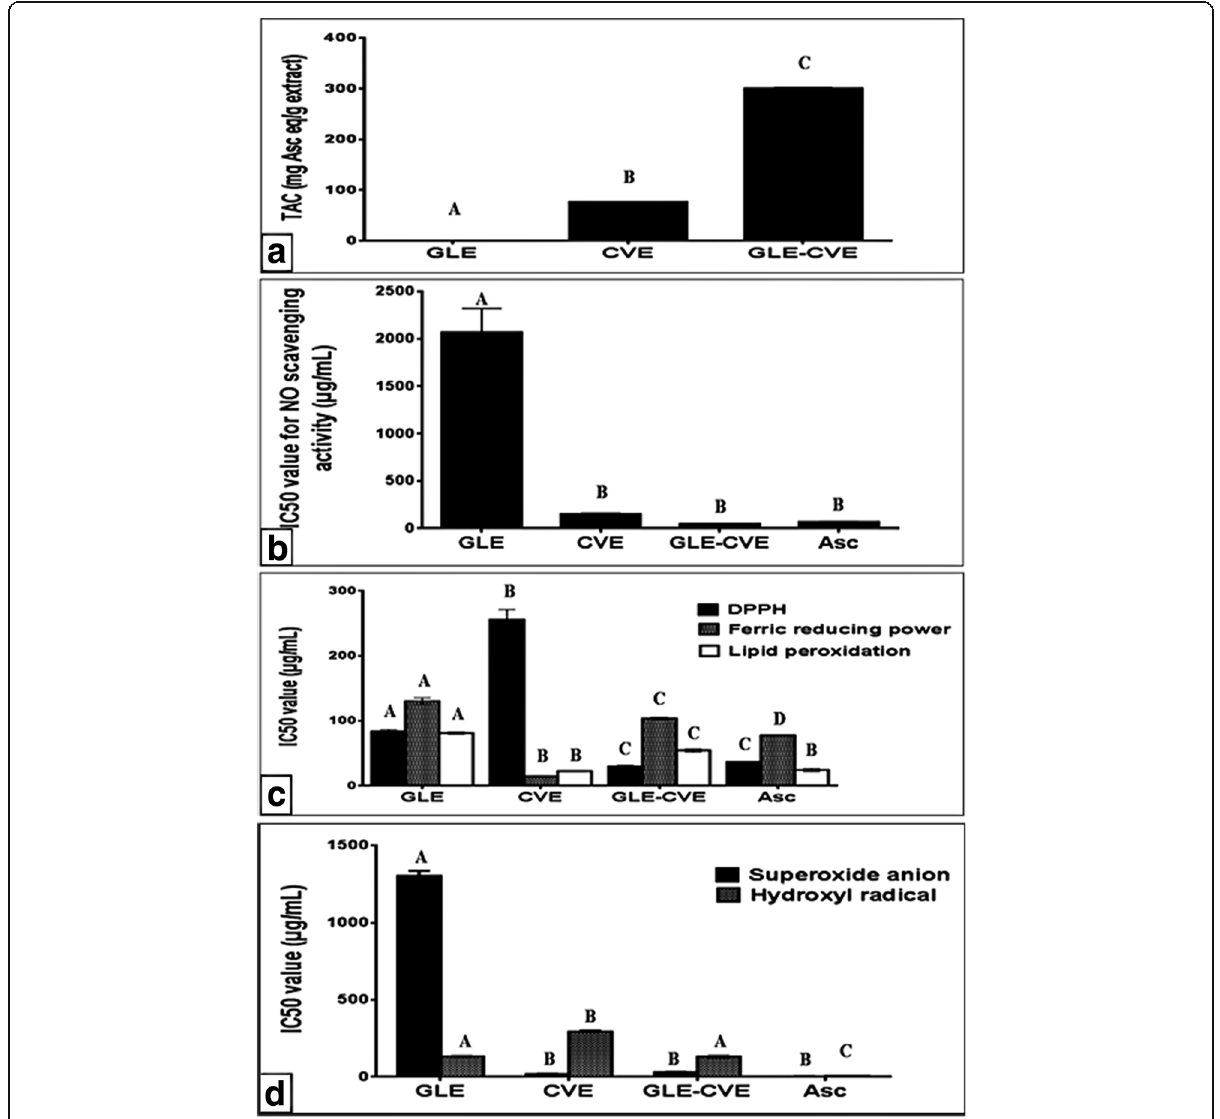
Fig. 2 In vitro antioxidant activities of GLE, CVE, and GLE-CVE combination in comparison with Asc. (a) Total antioxidant capacities (TAC) (b) NO scavenging activity (c) superoxide anion and hydroxyl radical scavenging activities, and (d) DPPH scavenging activity, anti-lipid peroxidation effect, and ferric reducing power. Results are expressed as Mean ± S.E. Different letters for the same parameter are significantly different at p <